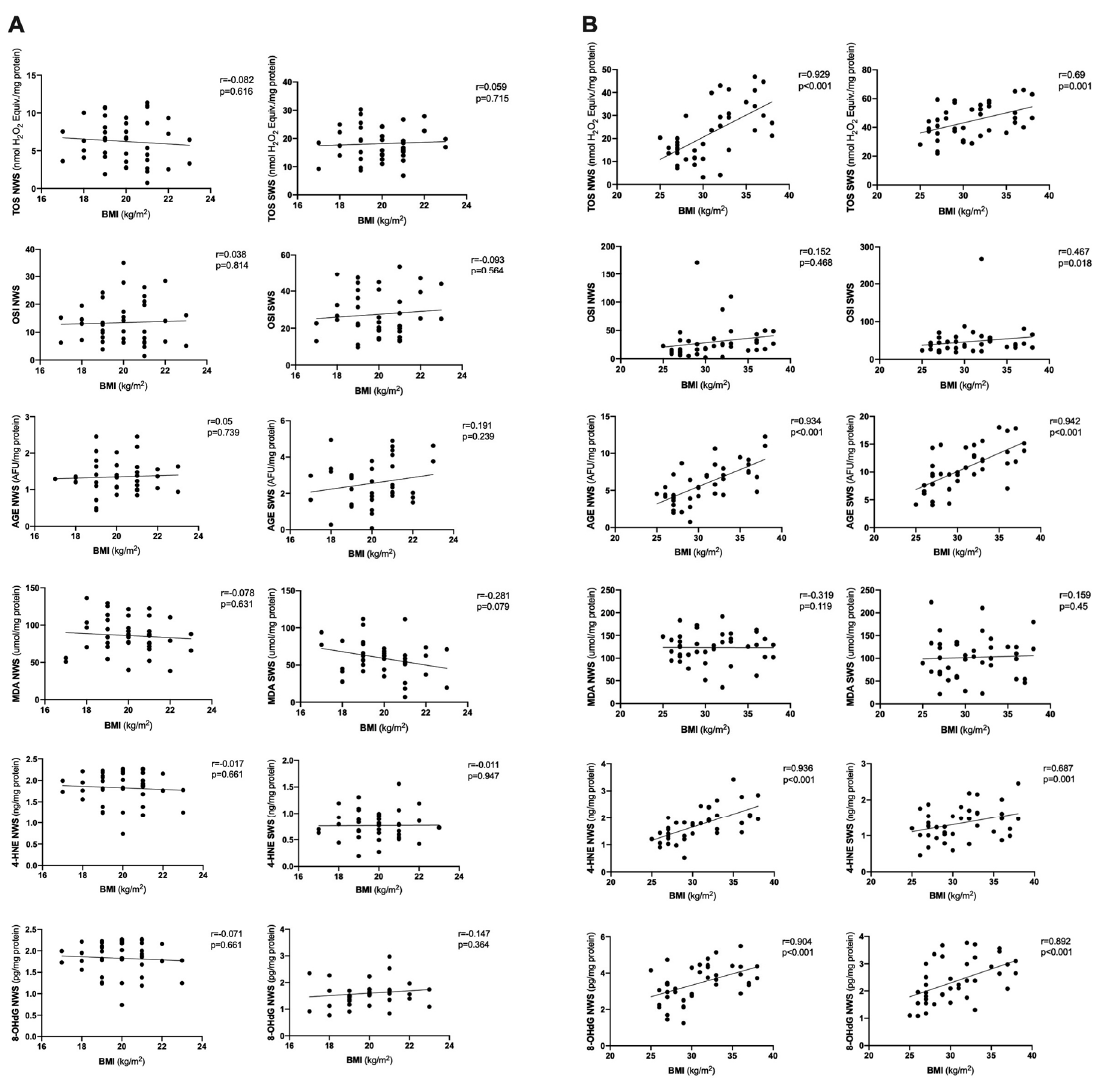
Figure 9. Correlations between BMI and salivary oxidative damage in healthy children ( A ) as well as overweight and obese adolescents ( B ). BMI- body mass index, AGE- advanced glycation end products, MDA- malondialdehyde, NWS- non-stimulated whole saliva, OSI- oxidative stress index, SWS- stimulated whole saliva, TOS- total oxidative status, 4-HNE- 4-hydroxynoneal protein adduct, 8-OHdG- 8-hydroxy-D-guanosine.